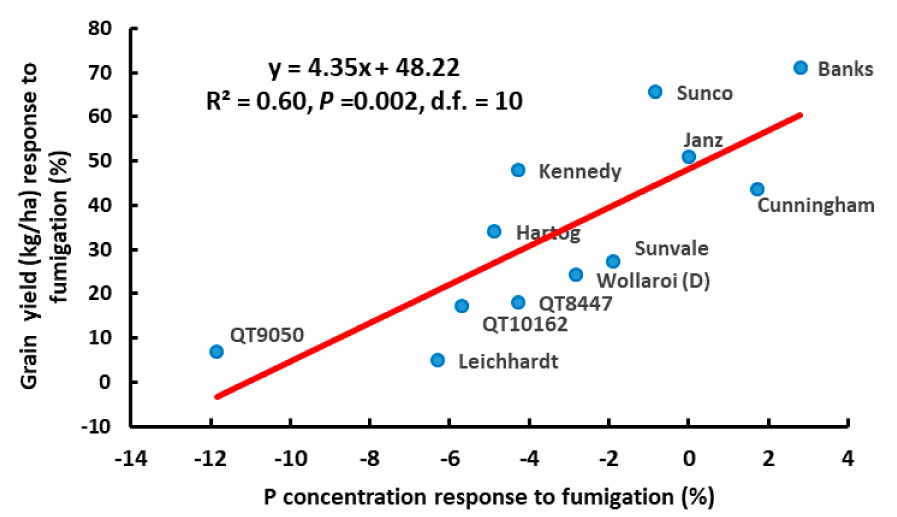
Figure 10. Relationship between response to fumigation of grain yield (kg/ha) and response to fumigation of phosphorus concentration (%) in wheat plants at Z32 (stem elongation) in Experiment